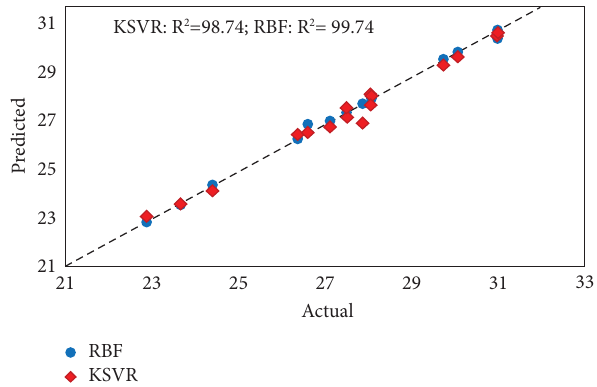
Figure 11: Actual and predicted values of CS by the RBF and KSVR models for total data.